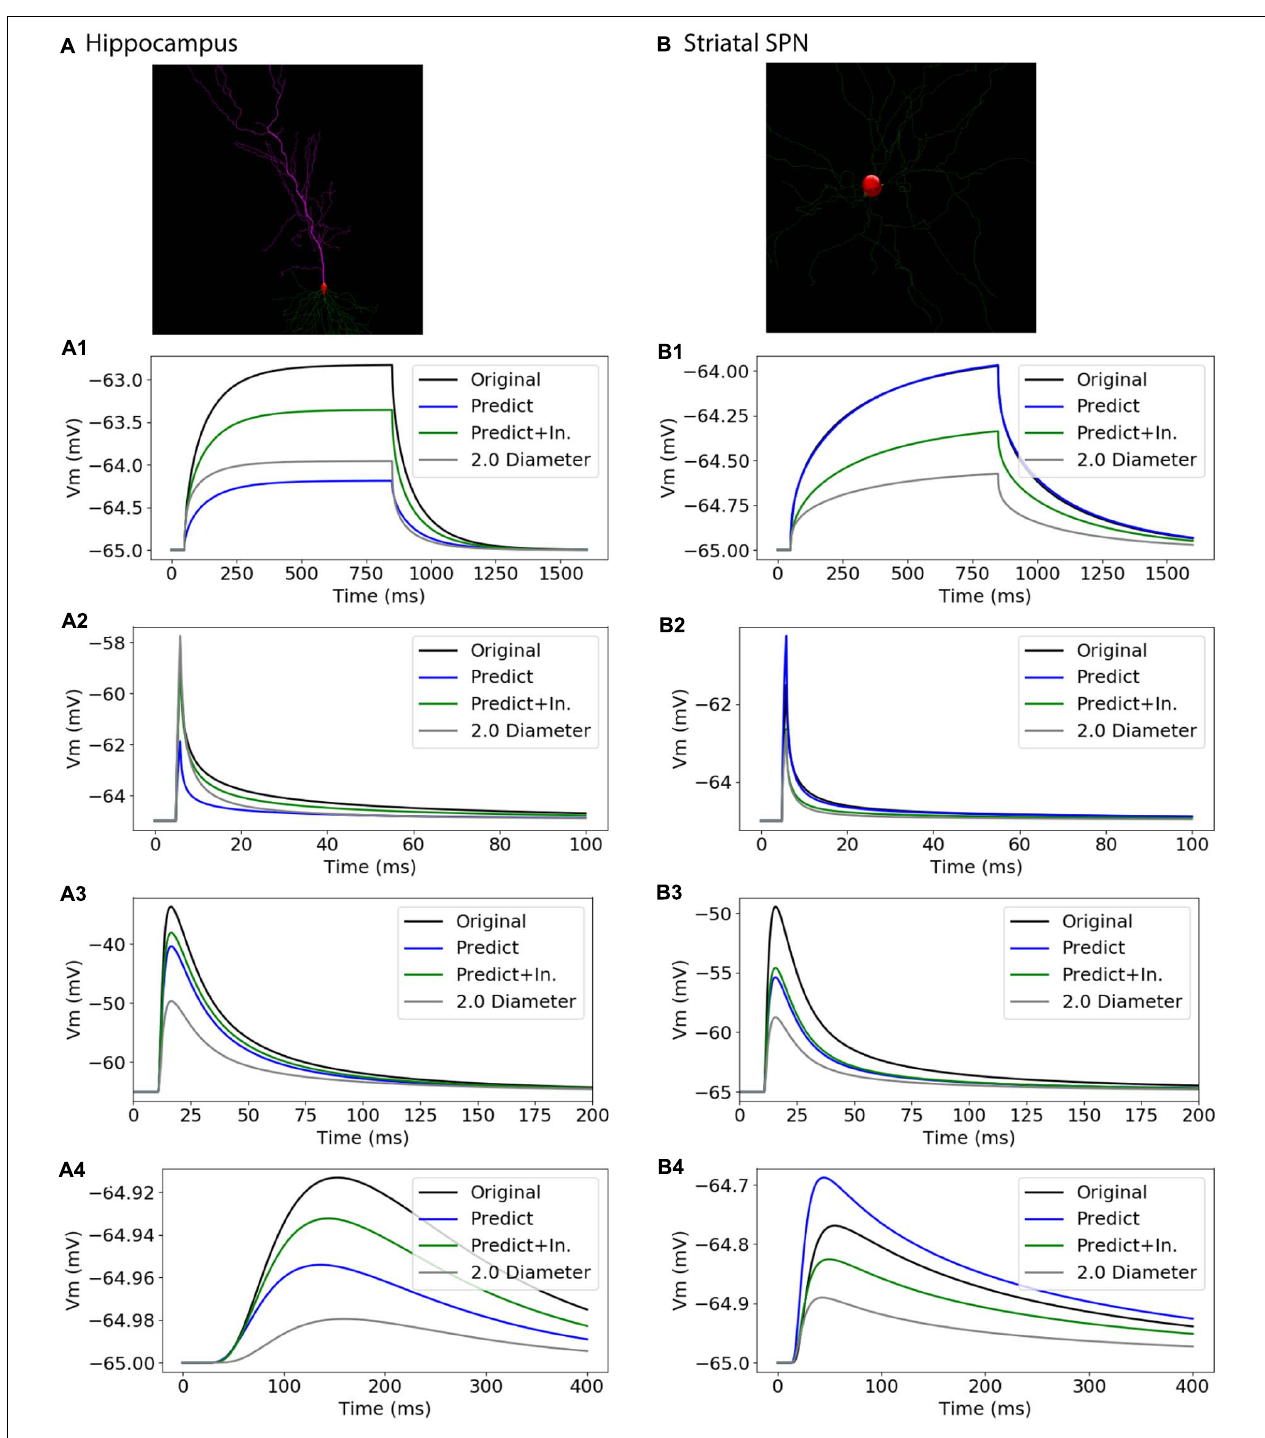
FIGURE 11 | Passive Response with predicted diameters + original initial diameters is similar to that of original diameters for morphologies in validation data. Normalized difference (ratio) was calculated for time constants ( τ ) and steady state ( (cid:49) V) to compare predicted morphology response to original morphology response. (A) Hippocampal CA1 pyramidal cell (NMO_00886), with apical and basal dendrites, synaptic input to compartment 31_4. (B) Striatal SPN (NMO_08390), synaptic input to compartment 35_3 (A1, B1) response to 800 ms somatic current injection. (cid:49) V ratio = 0.24 for hippocampus and 0.35 for striatum for morphologies with original initial diameter (A2, B2) response to 1 ms somatic current injection. τ 1 ratio = 0.12, τ 2 ratio = 0.01, for hippocampal neuron; τ 1 ratio = 0.08, τ 2 ratio 0.09 for striatal SPN for morphologies with original initial diameter. (A3, B3) dendritic response to 10 pS. (cid:49) V ratio = 0.14 for hippocampus and 0.33 for striatum for morphologies with original initial diameter. (A4, B4) somatic response to 10 pS conductance synaptic input to the